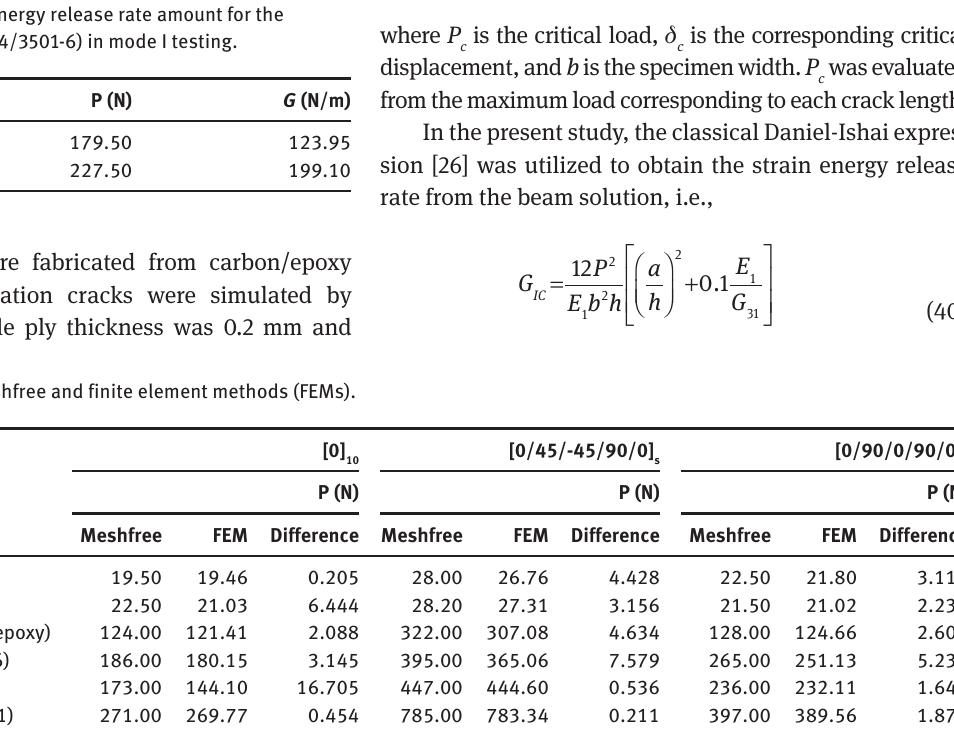
Figure 11 Load-displacement curve for the [0/90/0/90/0] epoxy laminate in the DCB test.